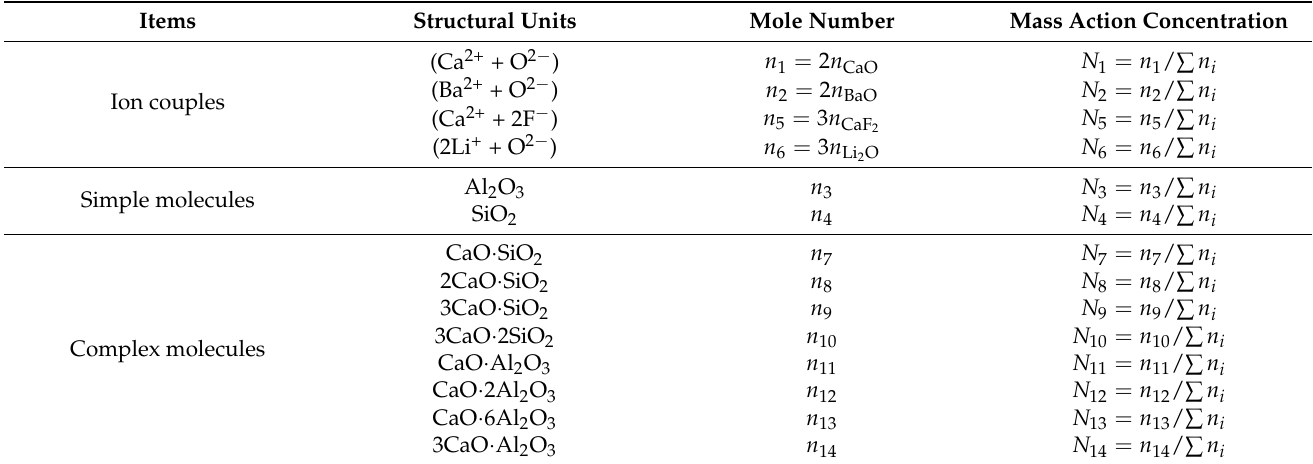
Table 1. Mole number and mass action concentration of the structural units. Structural Units Mole